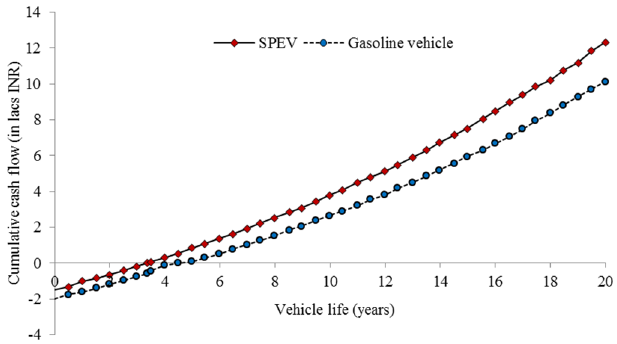
Figure 9. Cumulative cash flow analysis over SPEA lifetime.